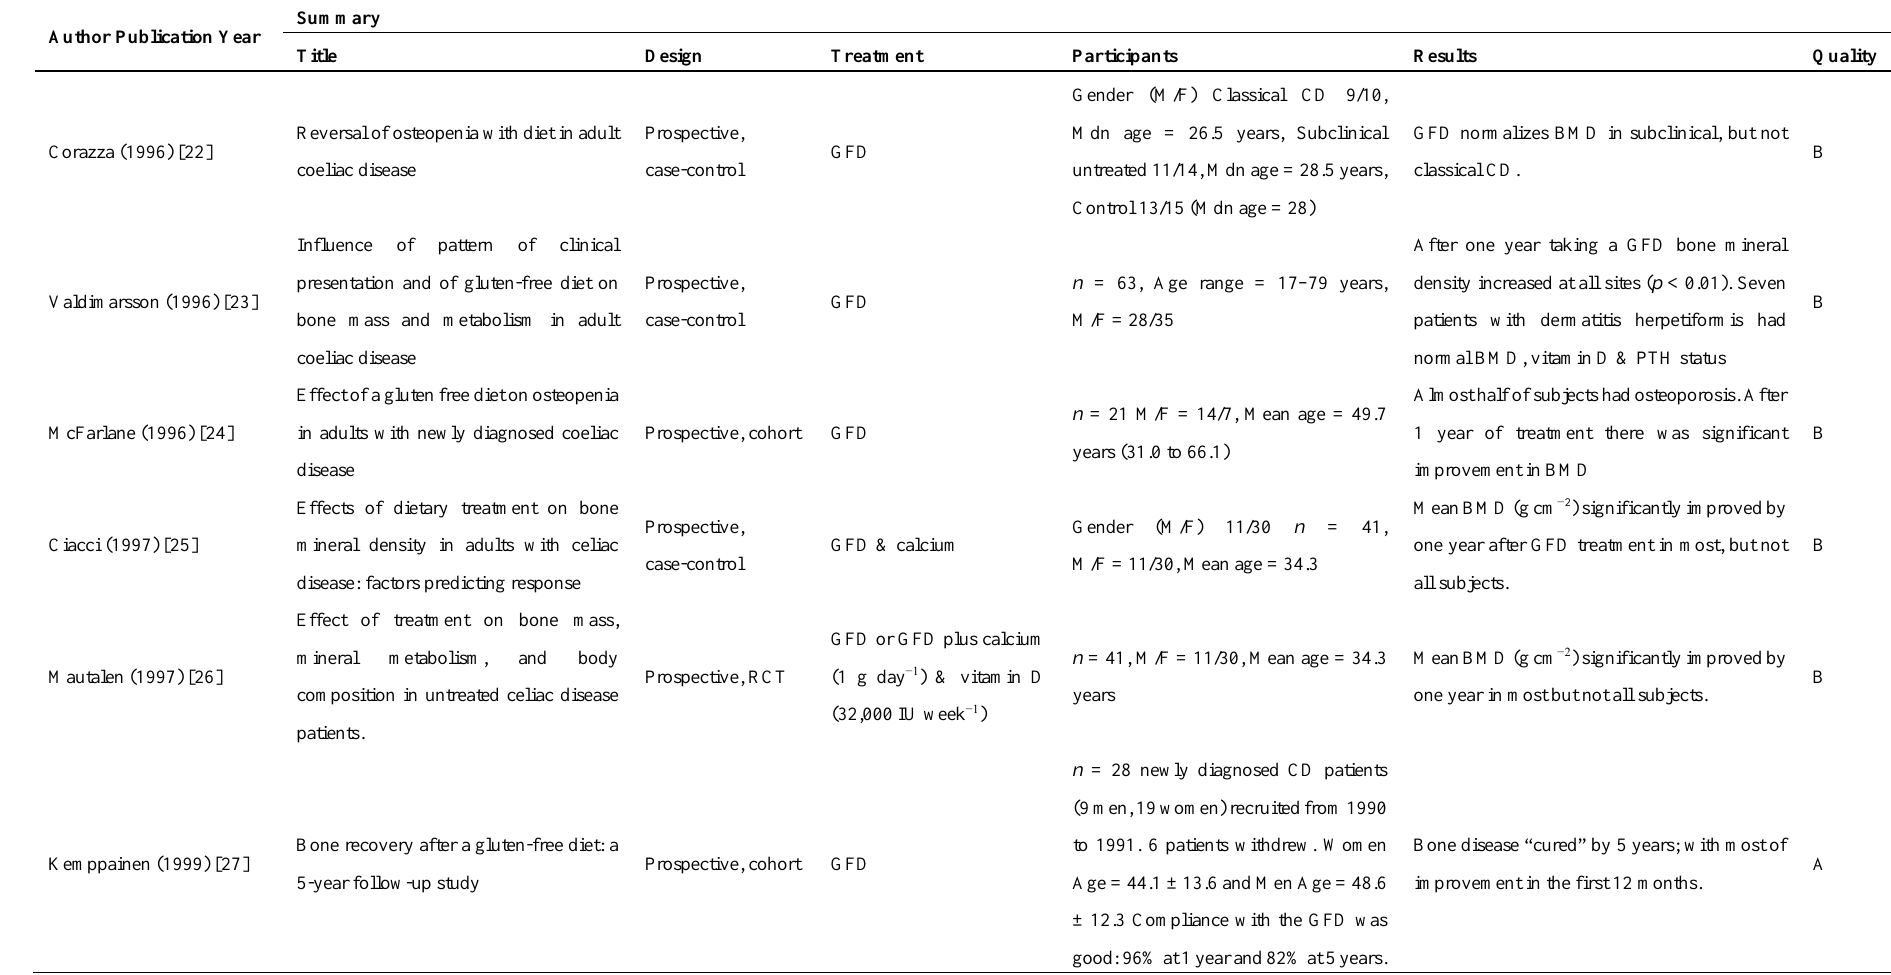
Table 1. Studies meeting search